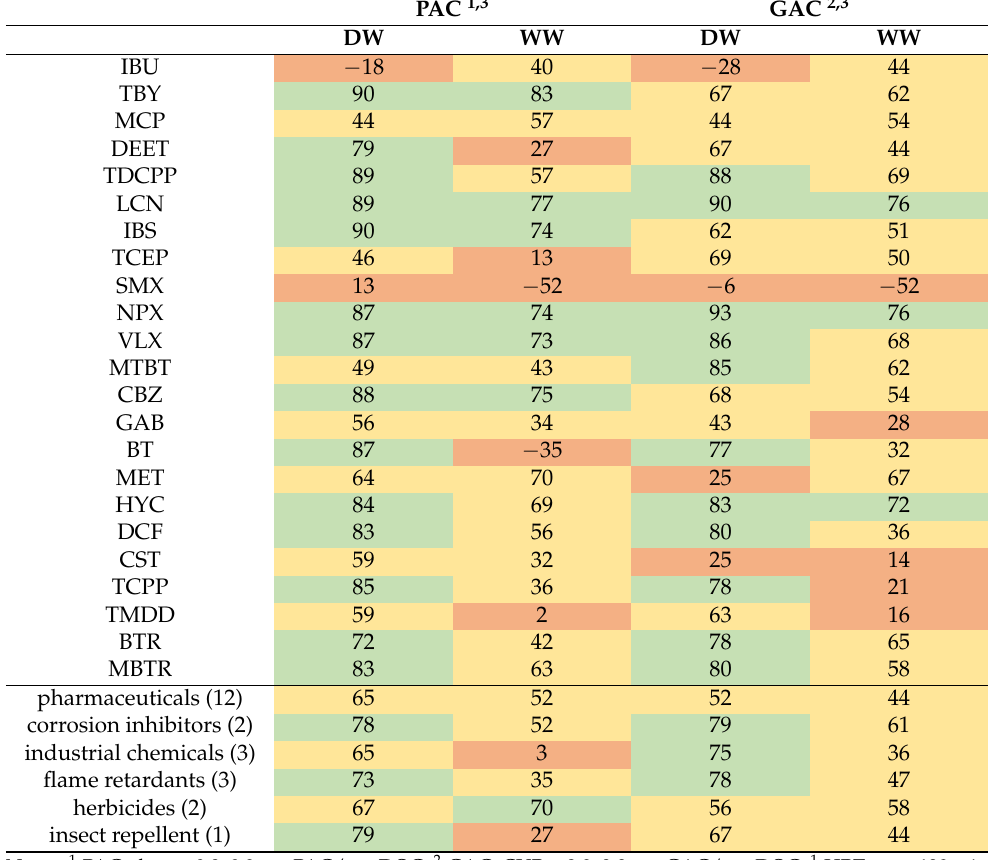
Table 2. OMP removal in % calculated from concentrations at SC and after activated carbon treatment (PAC and GAC) under DW (n = 1) and WW (n = 2) conditions; WW is the average removal calculated from WW1 and WW2; removal ≤ 30% = orange, 30% < removal ≤ 70% = yellow; removal > 70% =